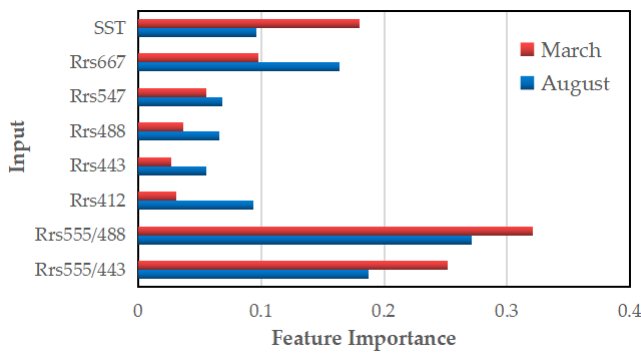
Figure 4. Feature importance of random forest